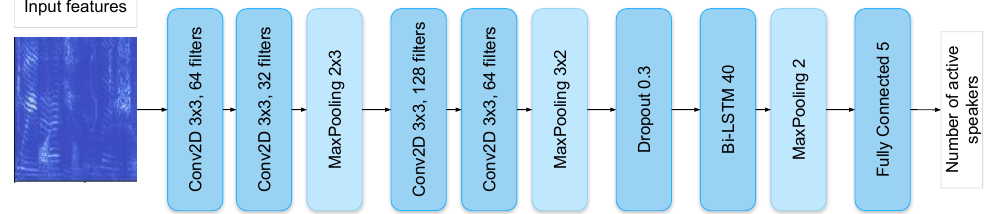
Figure 2. Speaker counter and overlapping speech detector model